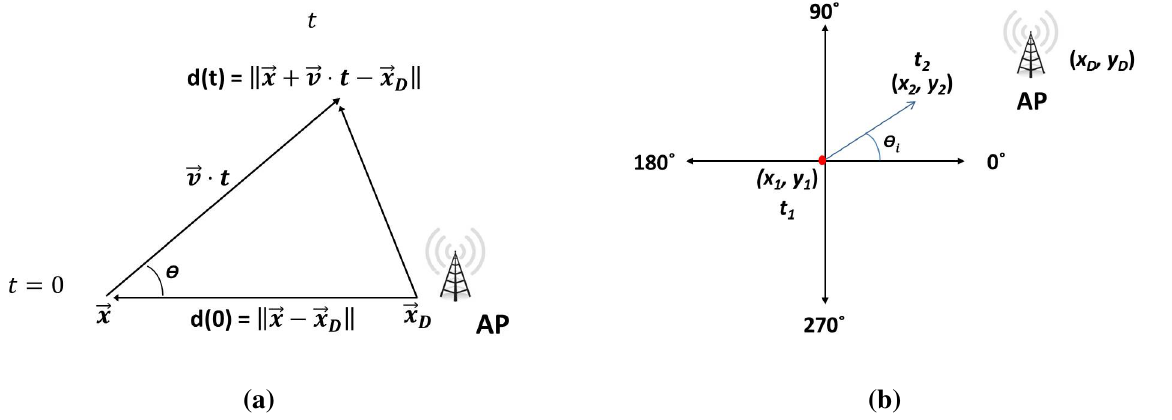
Figure 2. Trajectory towards the access point (AP) from two consecutive geographic